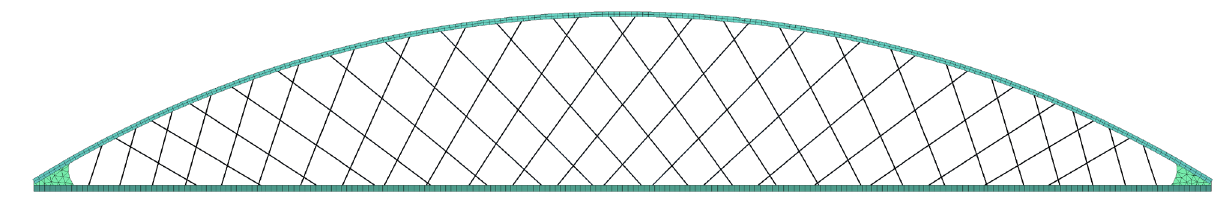
Figure 11: Side view of the numerical model.